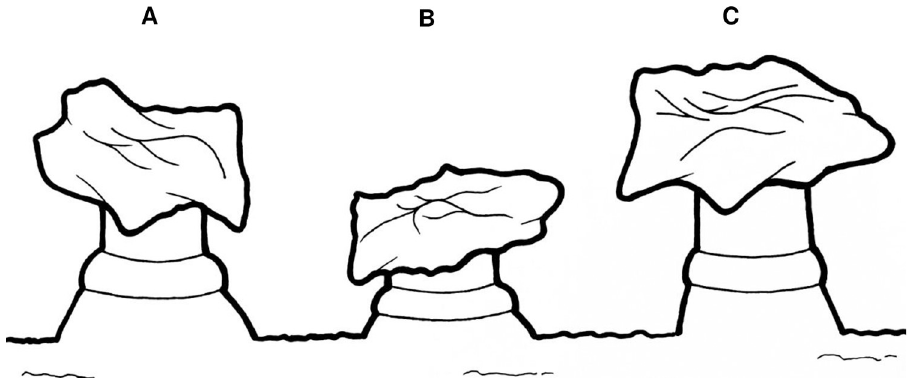
Fig 5. Drawing illustrating the morphological differences observed in the size and shape of the manifold in the three members of the Lu . longipalpis s.l. species complex. Campo Grande (A) , Sobral (B) and Jacobina (C) . https://doi.org/10.1371/journal.pntd.0009733.g005 were present on the internal cuticle surface of tergites III–VII. This distribution partially matched the distribution of the craters (with central pore and spike) previously reported on the external surface of tergites III-VI [37] (Fig 6A). The manifold was inserted within a deep